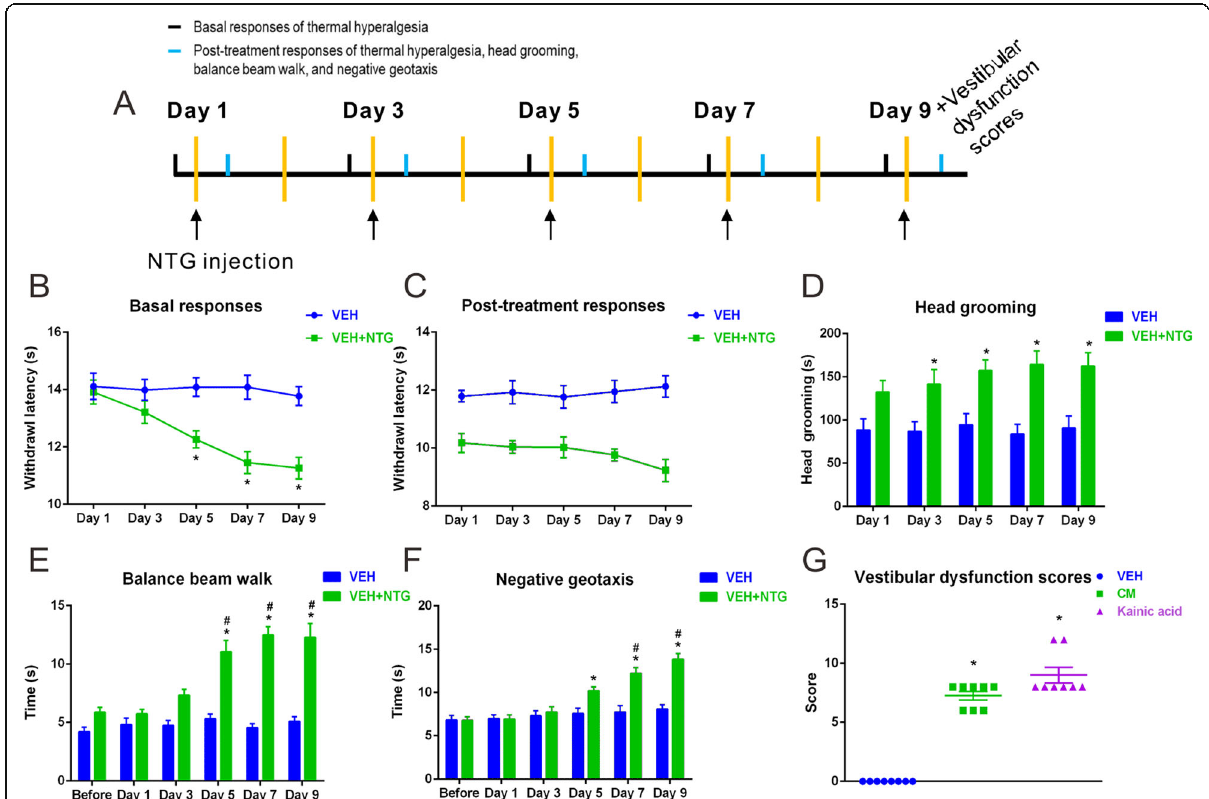
Fig. 1 Recurrent nitroglycerine (NTG) injection induced thermal hyperalgesia and vestibular dysfunction. a Timeline of behavior studies ’ protocol. b Basal and post-treatment responses ( c ) of hindpaw thermal hyperalgesia were markedly increased in a time dependent manner after NTG injection. d Head grooming time was significantly increased in NTG-treated rats compared with vehicle-treated group. Balance beam walk ( e ), geotaxis reflex ( f ) and vestibular dysfunction scores ( g ) showing that repeated NTG administration produced significant impairments in dynamic and static postural control compared with the vehicle group. n = 8/group. Data are mean ± SEM. Analysis of variance (ANOVA), Tukey; * p < 0.05 compared with vehicle, # p < 0.05 compared with before NTG